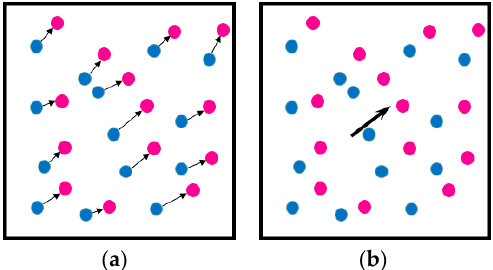
Figure 1. ( a ) Schematic of two-dimensional two-component (2D2C) Particle Tracking Velocimetry (PTV) measurement, where displacement of individual particles are measured ( b ) Schematic of a 2D2C Particle Image Velocimetry (PIV) measurement, where displacement is obtained from the highest peak in the cross-correlation function of a group of particles. Blue dots—initial position; red dots—final position.